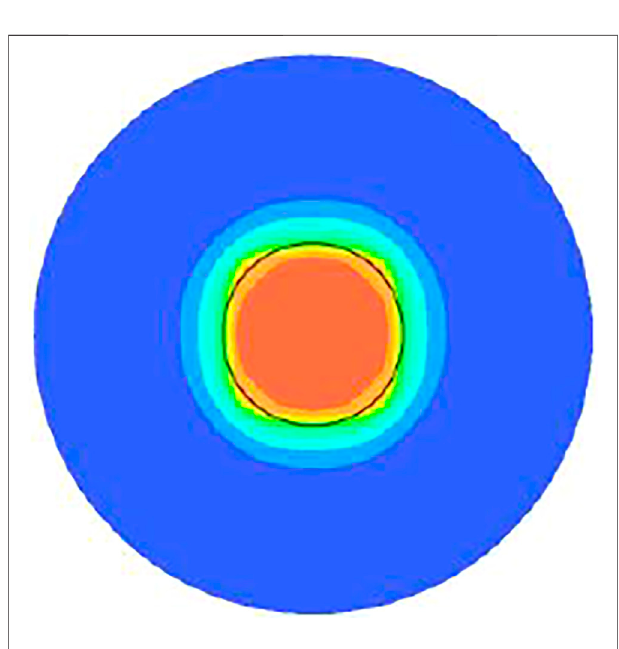
FIGURE 9 | Effective jet